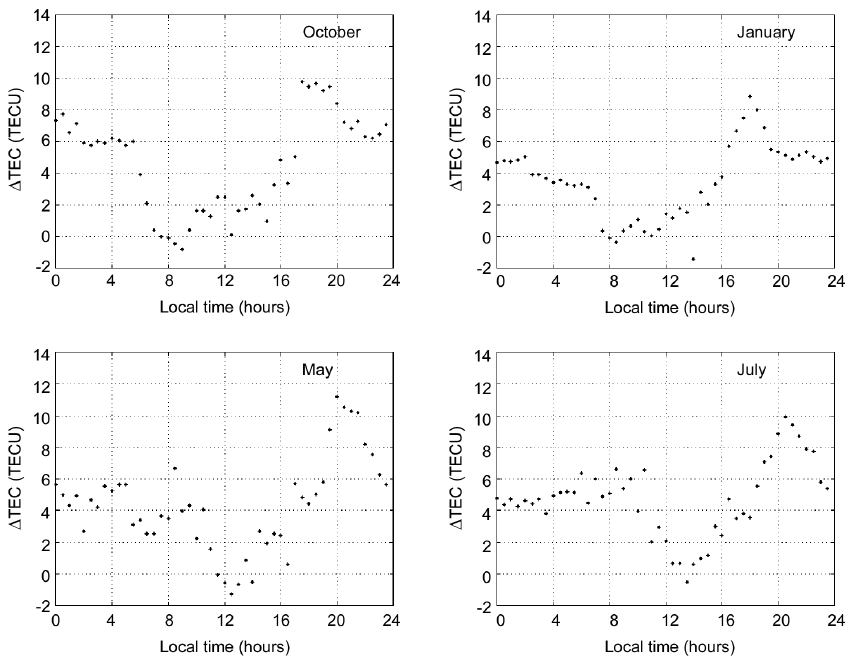
Fig. 6. The daily variation of the monthly median values of ∆ TEC over four months. A morning minimum and an evening maximum characterize the daily variation of ∆ TEC.